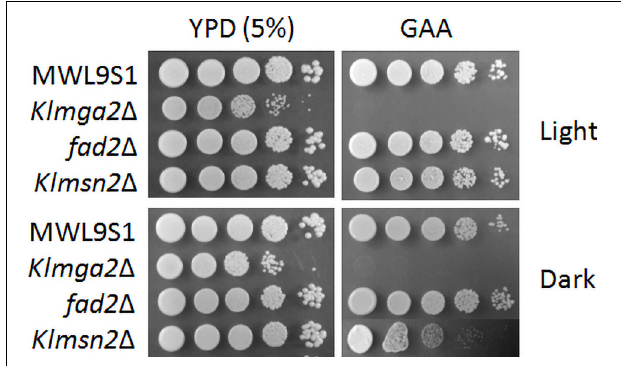
FIGURE 4 | Growth on different media of wild type strain MWL9S1 and mutant strains. Cultures were grown overnight in YPD at 28 ◦ C in light or dark conditions, serially diluted, and plated onto YPD plates (5% glucose) without or with antimycin A (GAA plates). Plates were incubated at 28 ◦ C under light or dark conditions for 3–4 days. Two or three independent cultures were performed for each strain/condition. Representative samples are